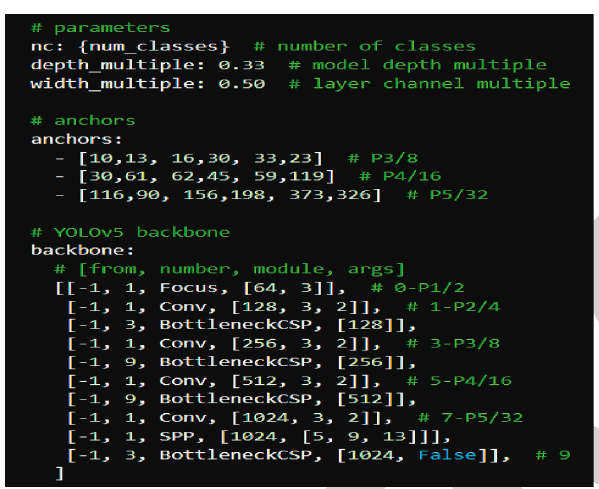
Figure 8: Parameters, anchors, and backbone used for YOLOv5 model.